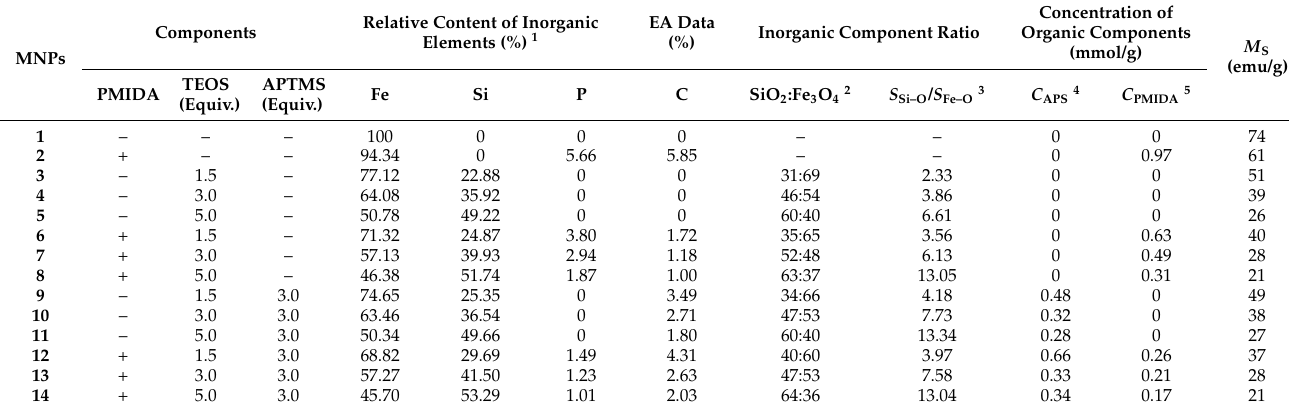
Table 1. Characterization of MNPs 1 – 14